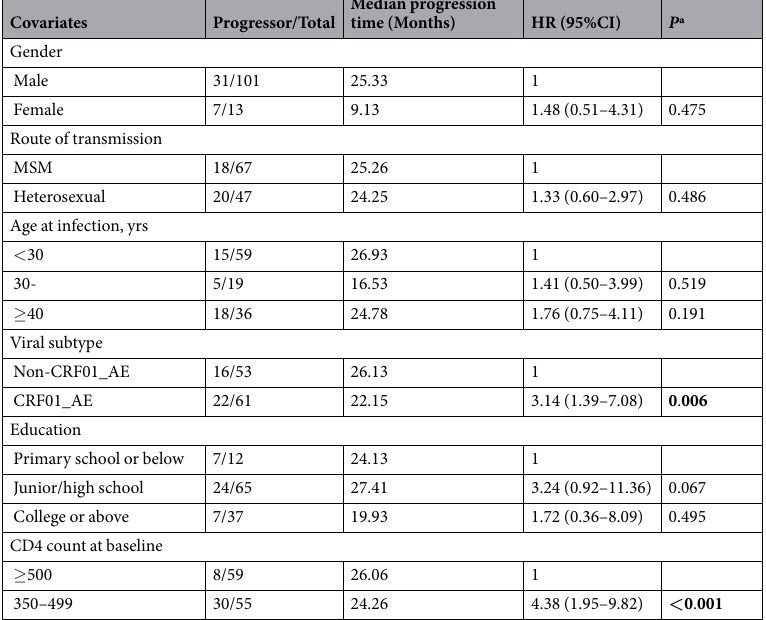
Table 2. Factors associated with HIV/AIDS progression (defined as time for CD4 + T-cell count decrease to < 350 cells/ μ L) using Cox proportional hazards model. Abbreviations: HR, hazard ratio; CI, confidence intervals. ª Cox regression with adjustment for gender, route of transmission, age at infection, viral subtype, education and CD4 count at baseline where necessary.